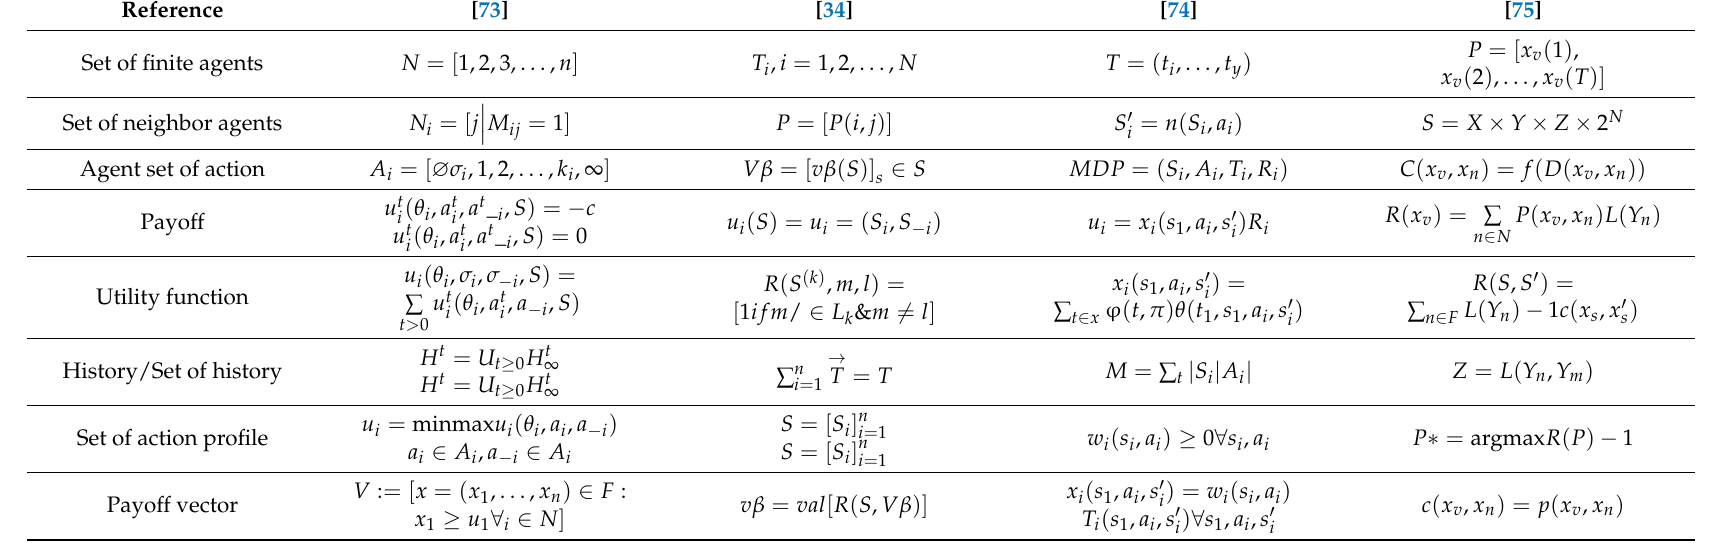
Table A1. Mathematical comparison of repeated game